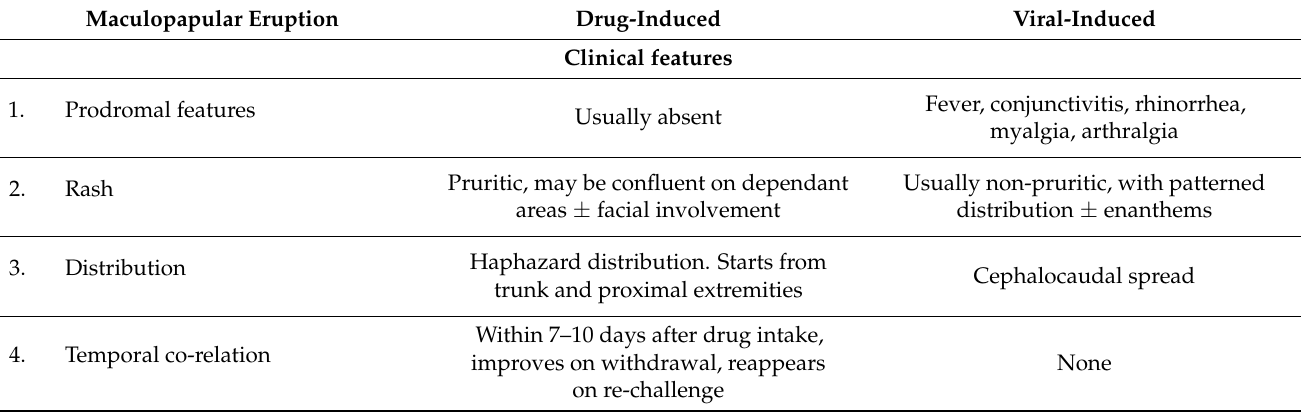
Table 1. Differentiation between drug-induced and viral maculopapular